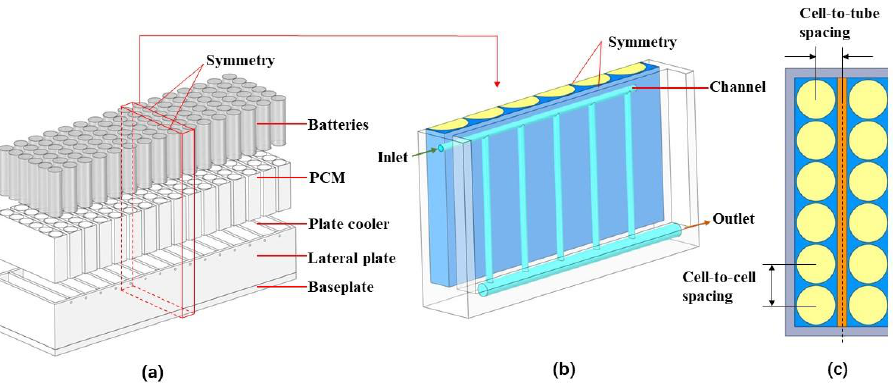
Figure 2. Schematic diagrams of the battery module heat dissipation configuration: ( a ) the overall system; ( b ) the internal flow channel of the cooling plate; ( c ) the cross-section view of the top of the battery. Table 2. Thermophysical parameters of coolant and PCM.